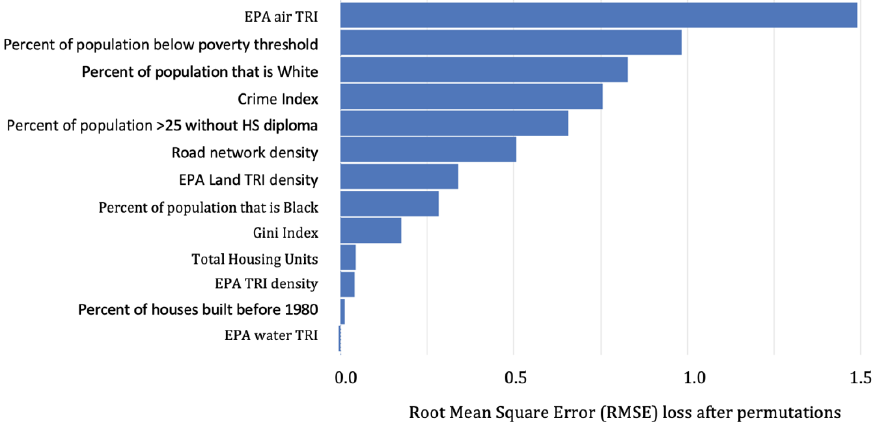
Figure 3. Partial dependence plots for top four ensemble predictors of the number of children in a raster cell with BLLs ≥2– <5 µg/dL.